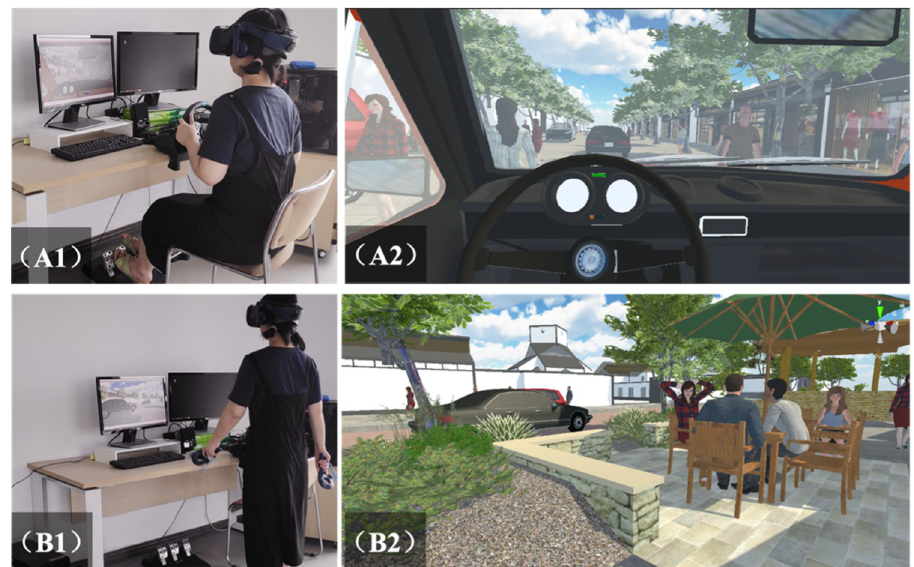
Fig 4. Experiment